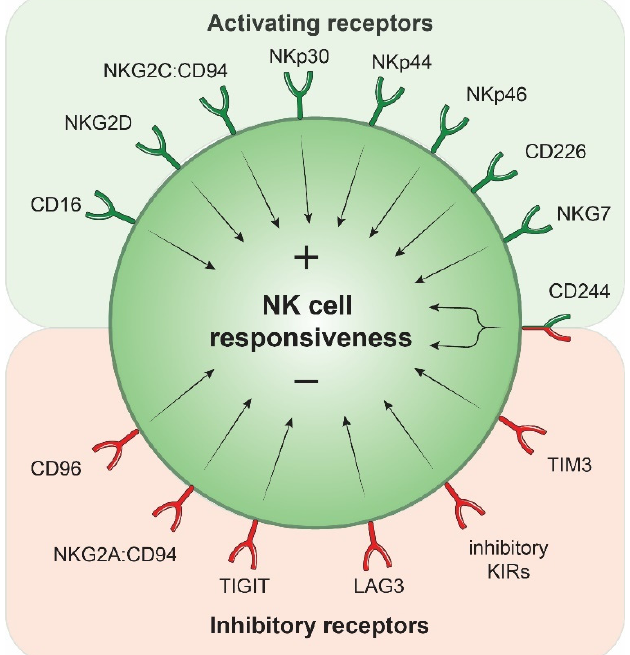
Figure 2. NK cell activating and inhibitory receptors. NK cell responsiveness is modulated by the engagement of activating or inhibitory receptors at the cell surface. TIM3, T cell immunoglobulin and mucin domain-containing protein 3.